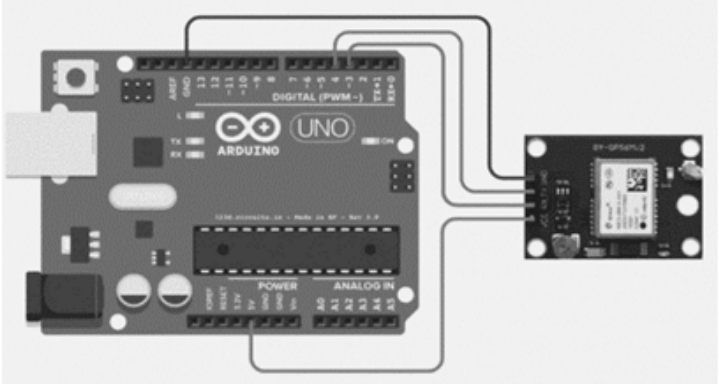
Figure 14. Wiring diagram of GPS 8M module connected to Arduino Uno board [69]. A sketch is uploaded to the Arduino Uno board (as shown in Figure 15) to obtain the location information on the serial monitor.